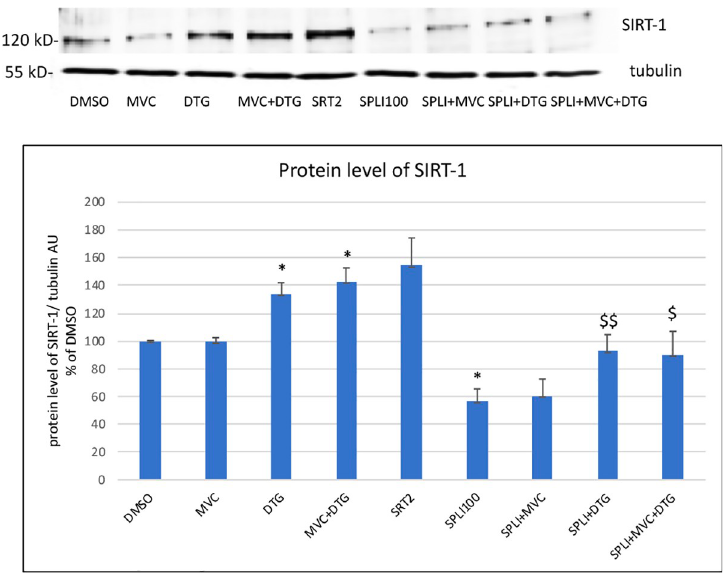
Fig 1. Effect of the antiretrovirals and of the SIRT-1 activator (SRT1720) and inhibitor (splitomycin) on the protein level of SIRT-1. A representative blot of SIRT-1 and tubulin as a loading control is shown. The histograms represent the mean+/-SEM value as compared to the DMSO control set at 100% of 4 independent experiments. The comparisons used Welch’s correction of Student T-test. SRT2: SRT1720 2 μ M, Spli100: splitomicin 100 μ M � p < 0.05 versus control (DMSO) $ p < 0.05, $ $ p < 0.01$ $ versus Spli100.